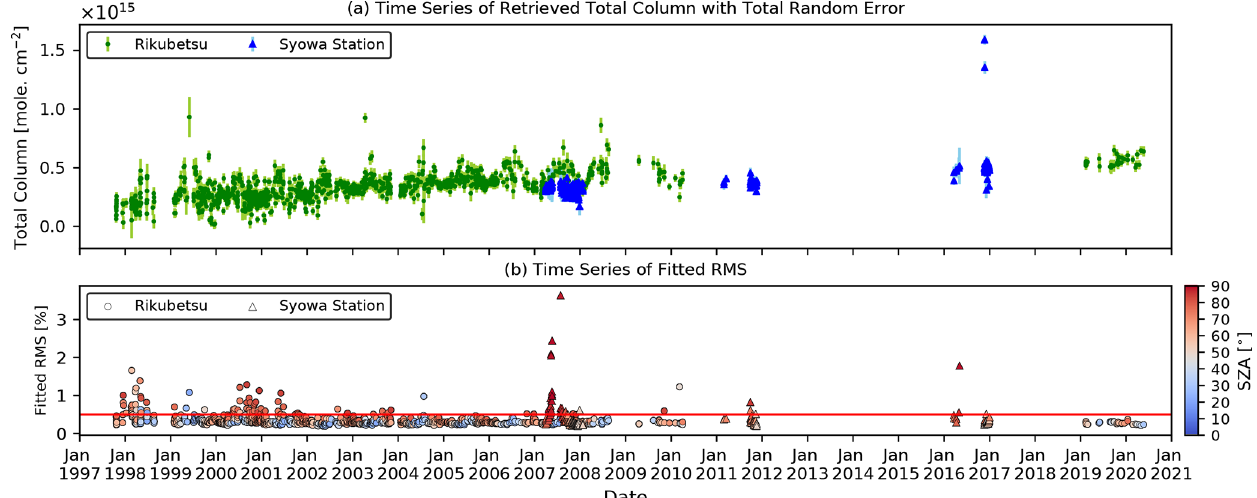
Figure 5. (a) Time series of FTIR-retrieved HFC-23 total columns with total random errors at Rikubetsu and Syowa Station. (b) The fitted rms values for an individual retrieved total column. The total columns at Rikubetsu and Syowa Station are shown by green circles and blue triangles, respectively. The fitted rms values at Rikubetsu and Syowa Station are shown by circles and triangles, respectively, with the color coding depended on the SZA.